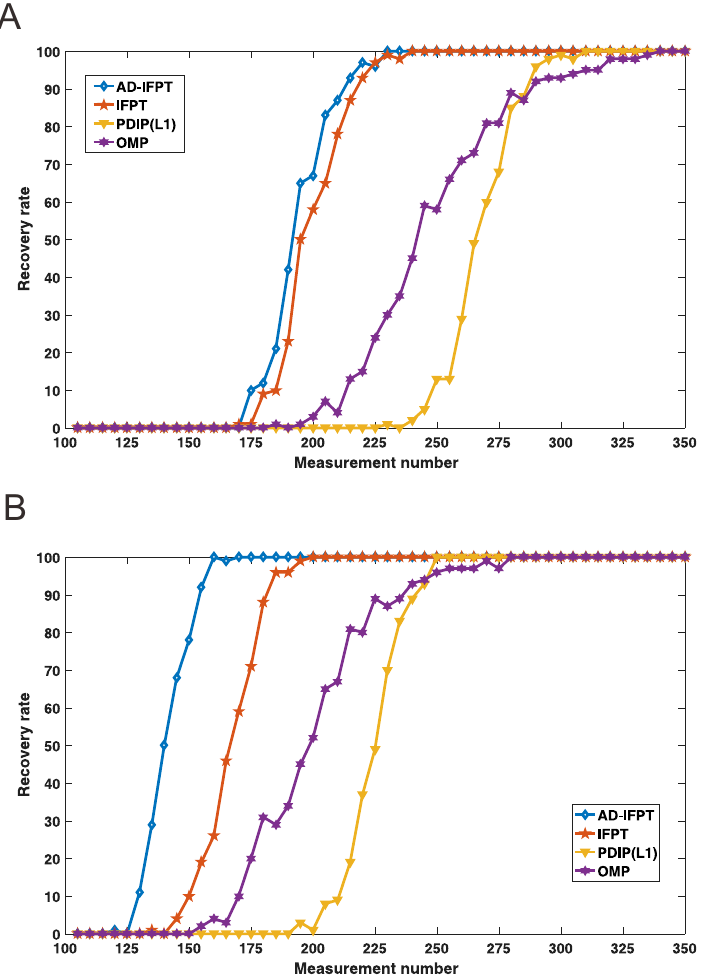
Figure 6. ( A ) Comparison of the recovery rate of 4 algorithms with abnormal events; ( B ) comparison of the recovery rate of 4 algorithms without abnormal